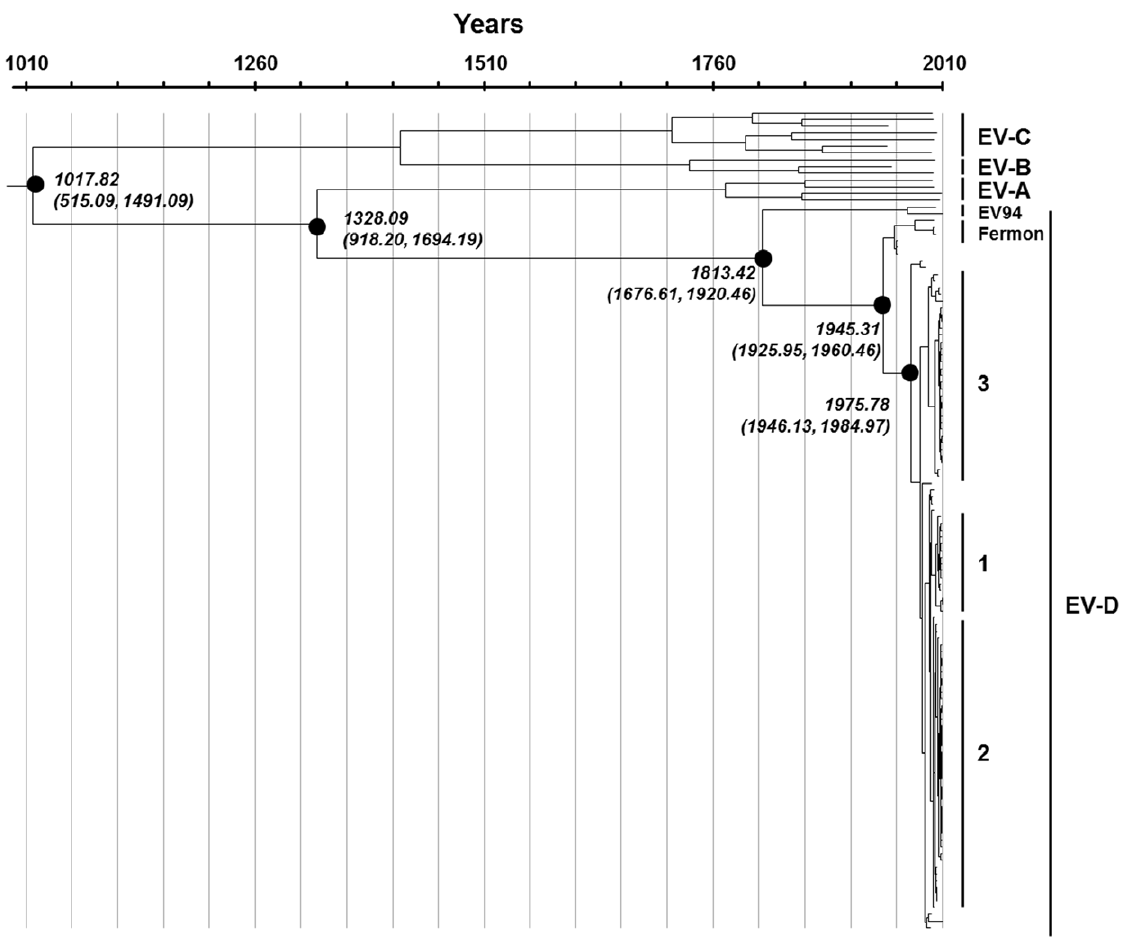
Figure 3. Bayesian time-scale phylogeny of EV68 and other EVs based on the partial VP1 sequence analysis (dataset 1 containing 122 sequences with 723 nt in length). Maximum clade credibility tree obtained with BEAST with a constant size coalescent prior showing lineage splitting events since the most recent common ancestor to the presently circulating EV68 strains. The divergence times correspond to the mean posterior estimate of their ages. For the TMRCA, the correspondent 95% Bayesian credible intervals are shown. Time axis is shown in years and ranges from the TMRCA to the present year.